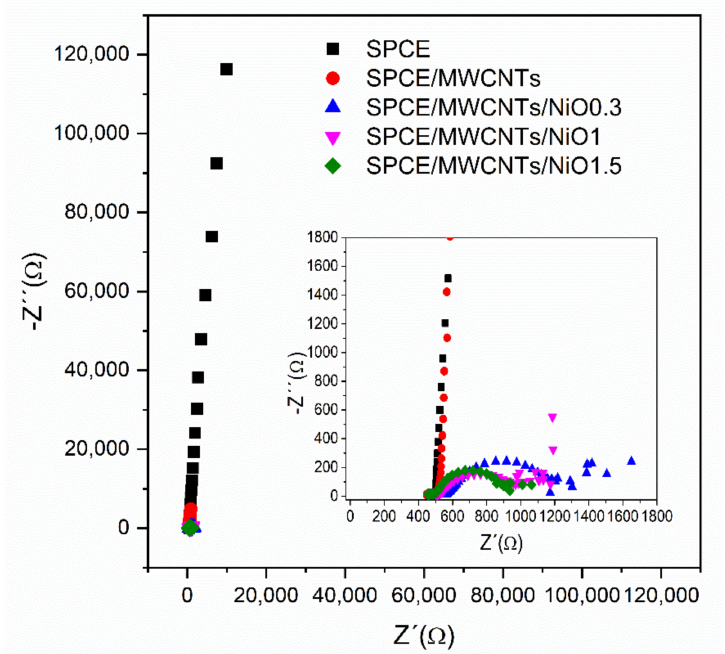
Figure 7. Impedancespectraat0.7V(vs. Agpseudo-referenceelectrode)fortheparticularmodificationsof thescreen-printedelectrodes: SPCE—blackcurve, SPCE/MWCNT—redcurve, SPCE/MWCNT/NiO0.3— blue curve, SPCE/MWCNT/NiO1—pink curve, SPCE/MWCNT/NiO1.5—green curve.